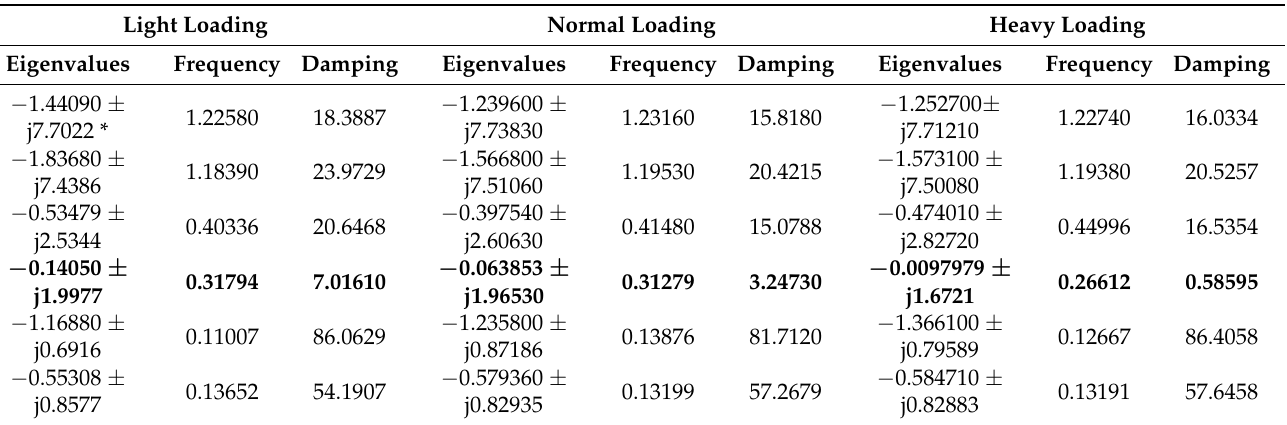
Table 3. Open-loop oscillation modes of IEEE 4-Machine Power System. Light